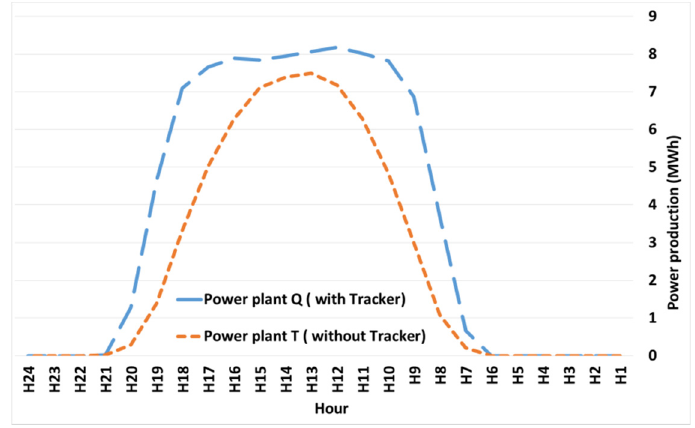
Figure 3. Actual daily energy production of the power plants Q (with a tracker) and T (without a tracker) on 22 June 2020.